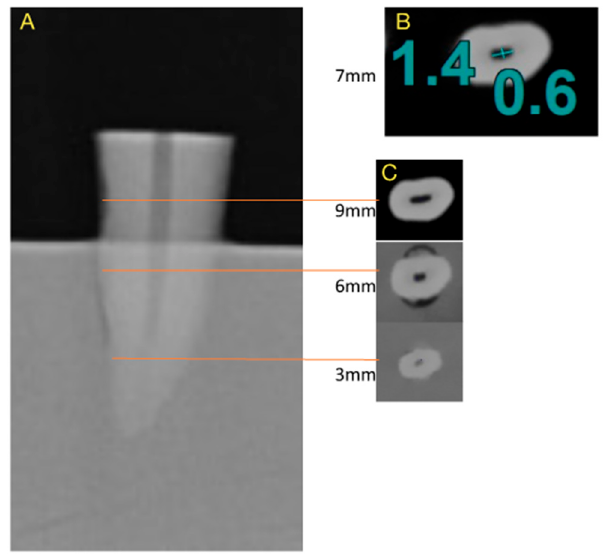
Figure 2. Sample selection. Preoperative X-ray ( A ). Preoperative CBCT: mesiodistal and buccolingual diameters of each root canal were measured at 7 mm from the apex to ensure the oval shape of the root canal ( B ). Axial section at 3, 6, and 9 mm from the apex ( C ).